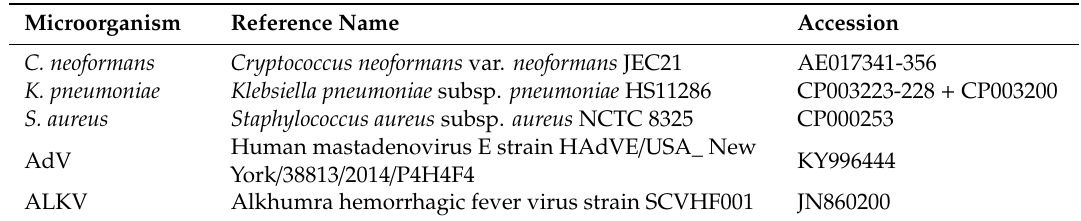
Table 1. Genome sequences used for reference mapping in this